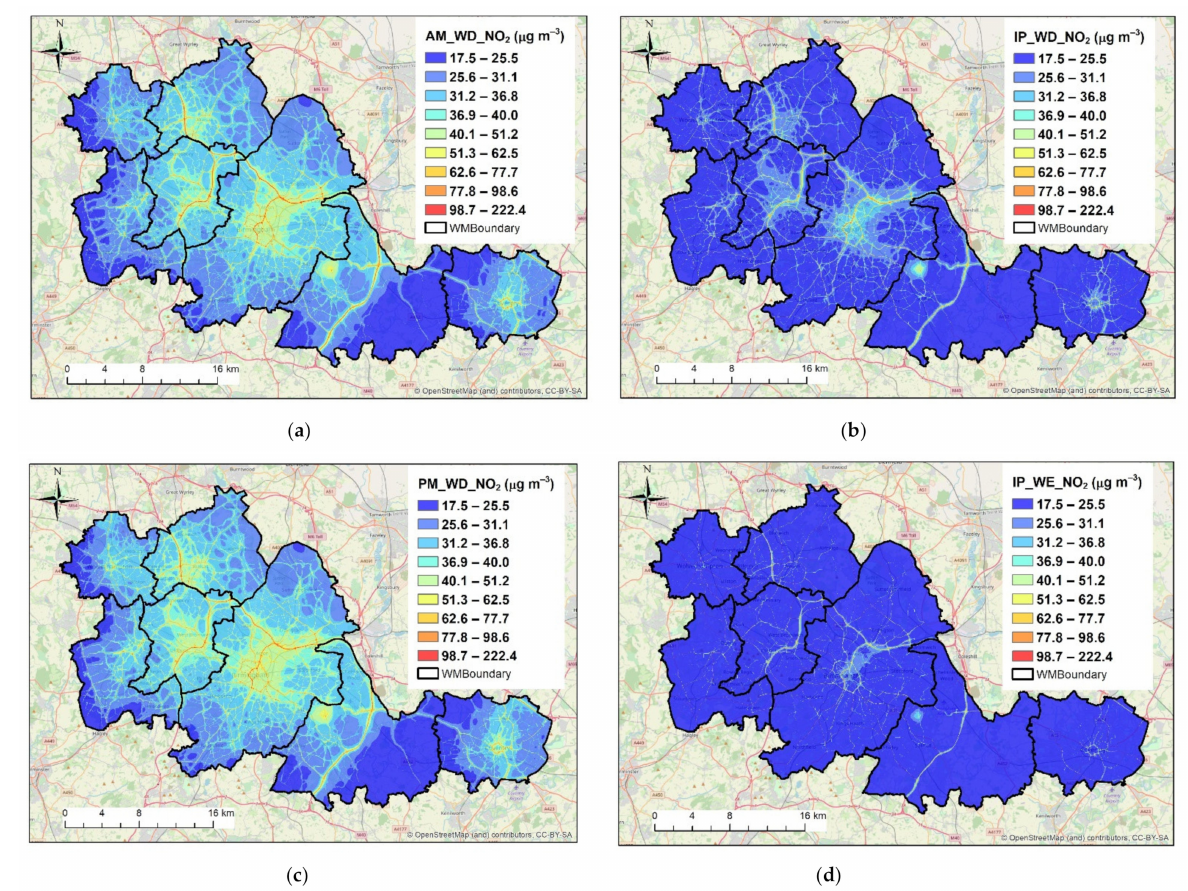
Figure 10. Air quality maps for NO 2 (in µ g m − 3 ) at 10 m × 10 m resolution averaged over ( a ) AM weekday, ( b ) IP weekday, ( c ) PM weekday, ( d ) IP